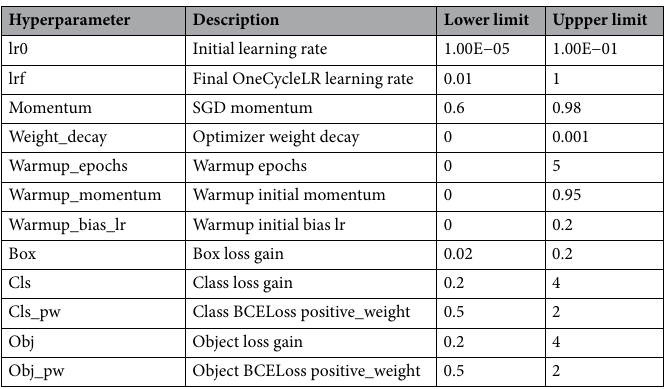
Table 2. 12 hyperparameters in YOLOv5.